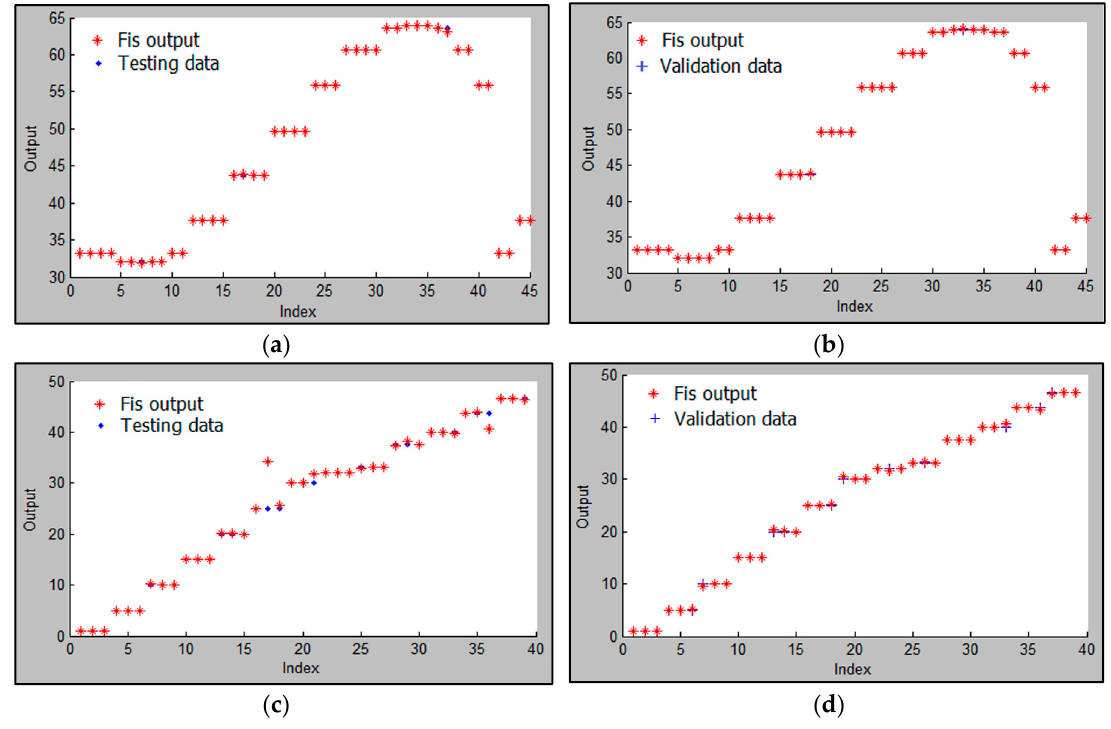
Figure 12. Comparison of transient characteristics for ANFIS ( a ) testing and ( b ) validation data for the outdoor velodrome and ( c ) testing and ( d ) validation for the indoor velodrome.